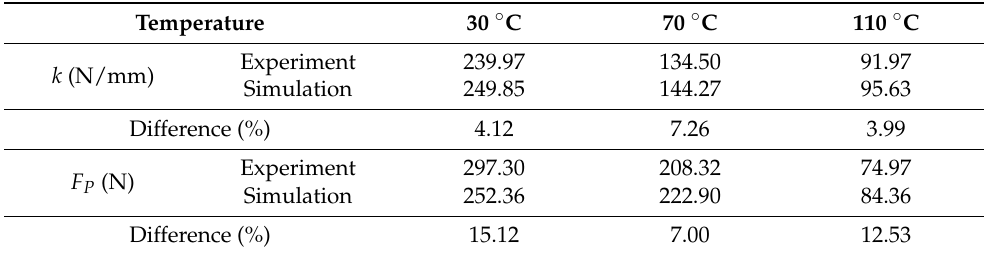
Figure 6. Mode-II load–displacement curve validation between experiment and simulation at ( a ) 30, ( b ) 70 and ( c ) 110 °C. Table 6. Mode-II slope and peak load data comparison between experimental and simulation re- sults.